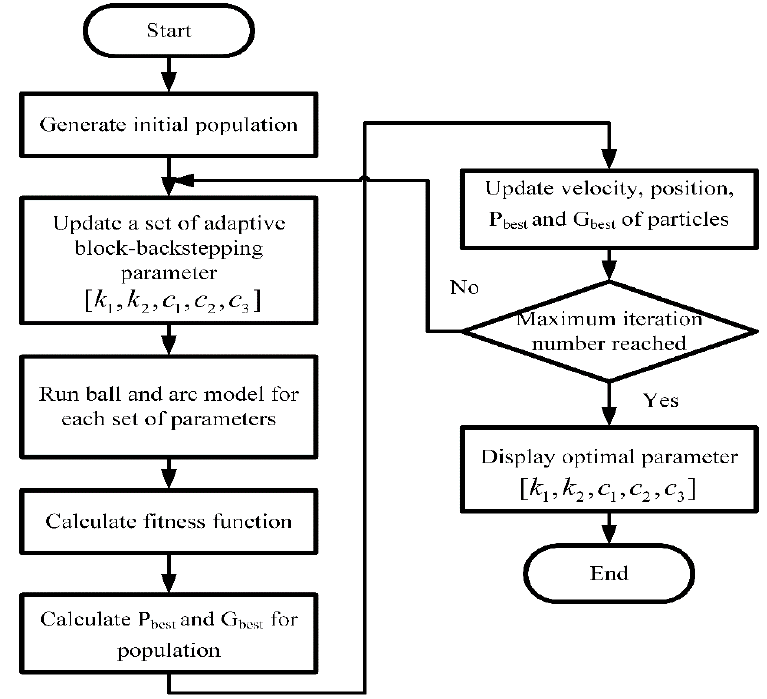
Figure 2. The particle swarm optimization (PSO) algorithm for the adaptive controlled system.